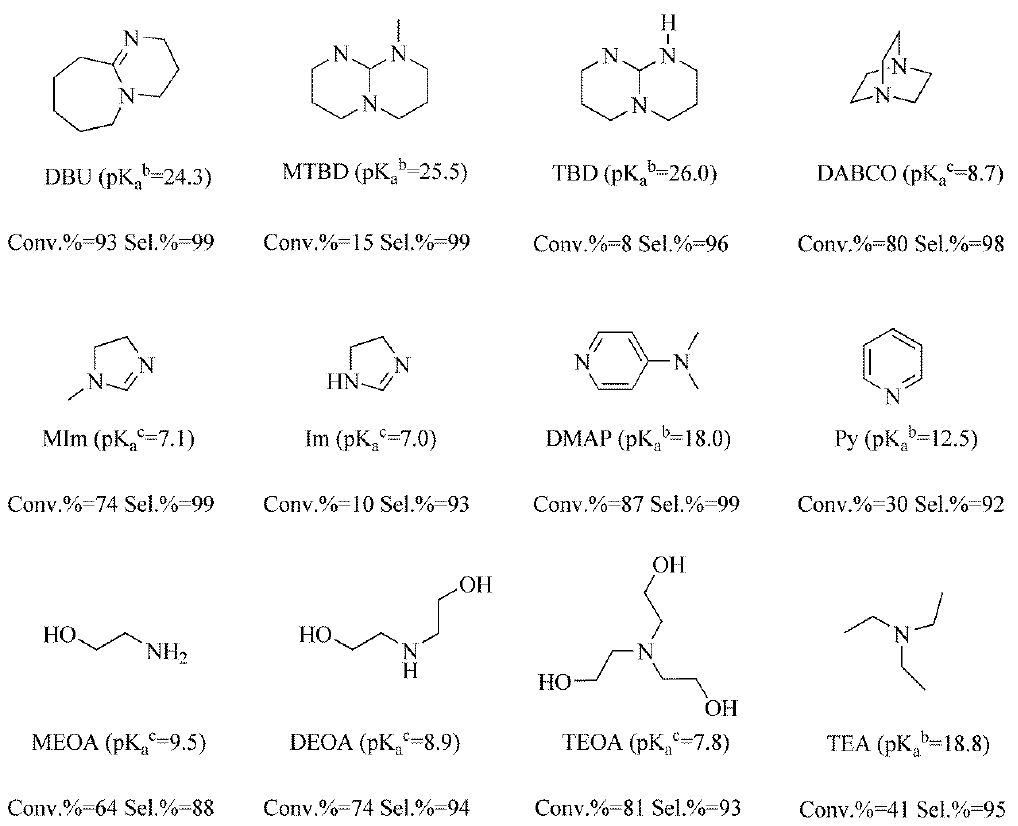
Table 2. Summary of reaction conditions and yields for epoxides conversion to cyclic carbonates using biomass/co-catalysts (propylene oxide (PO)).